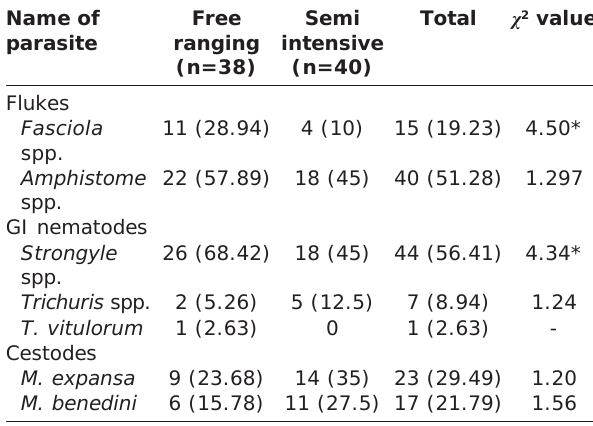
Table-1: Prevalence of different helminth parasites in